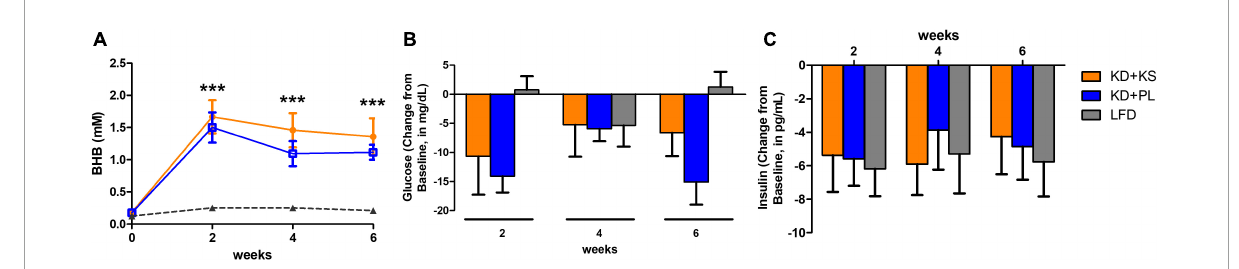
FIGURE2 Fasting beta-hydroxybutyrate [BHB, panel (A) ], glucose (B) and insulin (C) concentrations collected on testing days over the course of 6 weeks. Values at each week represent mean ± SEM. KD, ketogenic diet; KS, ketone supplement; PL, placebo; LFD, low-fat diet. *** p < 0.001 from baseline (week 0) representing significant differences in both KD groups (KD + KD and KD + PL) compared to LFD group.